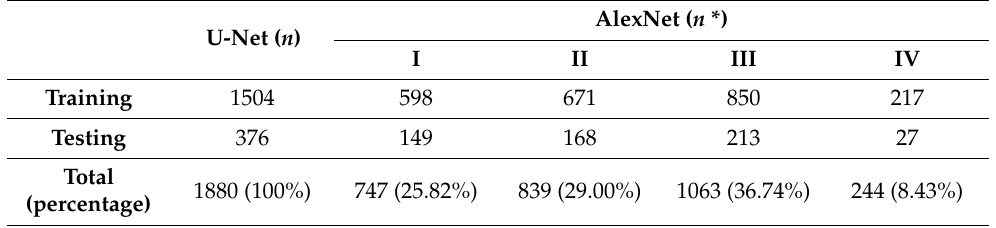
Table 1. Distribution of the data for training and testing groups. For U-Net, the n represents the number of OPGs, whereas the n * represents the number of image patches for AlexNet. U-Net ( n